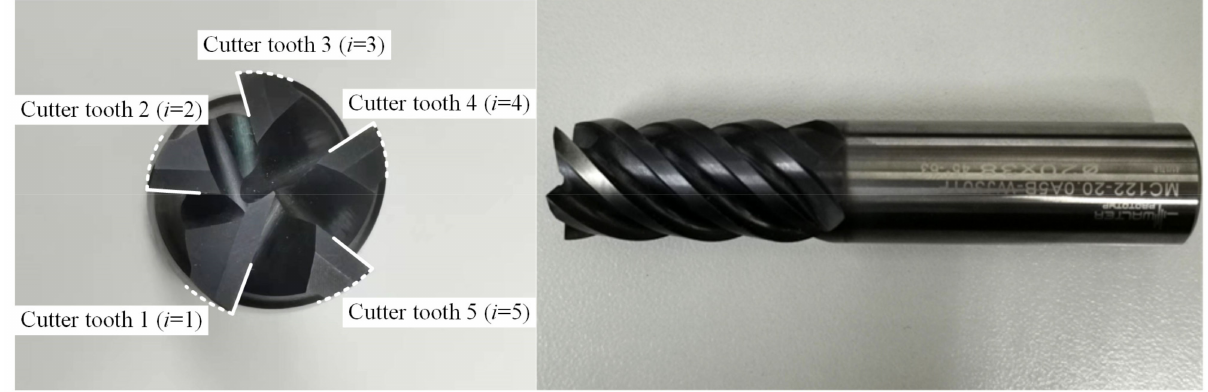
Figure 5. Milling cutter structure and cutter tooth serial